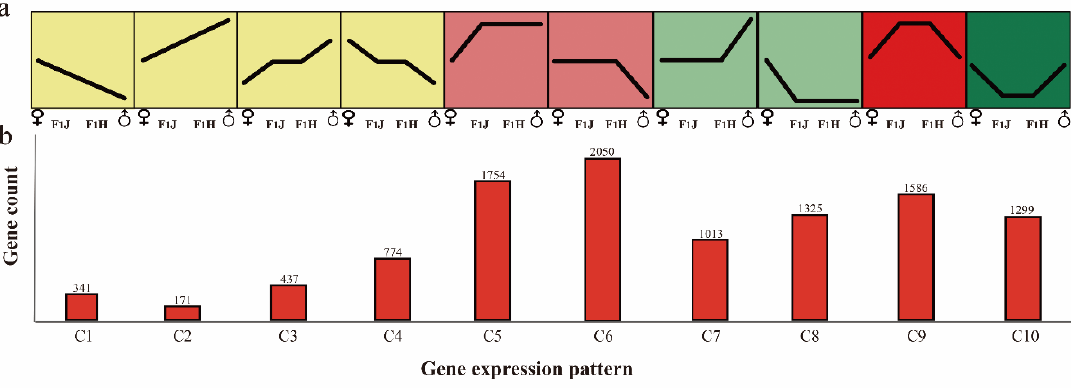
Figure 2. Ten gene expression patterns involved in additive or non-additive expression. ( a ) Expression patterns of 10 types of genes. “ ♂ ” means male parent; “ ♀ ” means female parent; “ F1J ” means JGY; “ F1H ” means HGY. ( b ) The gene number of each pattern. “C” means gene cluster.